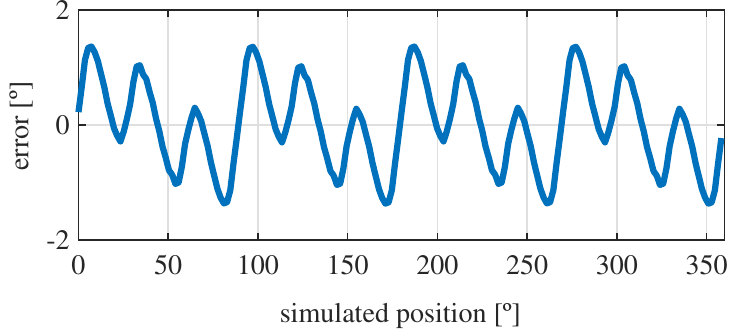
Figure 27. Full pitch twelve-slot skewed resolver position error.